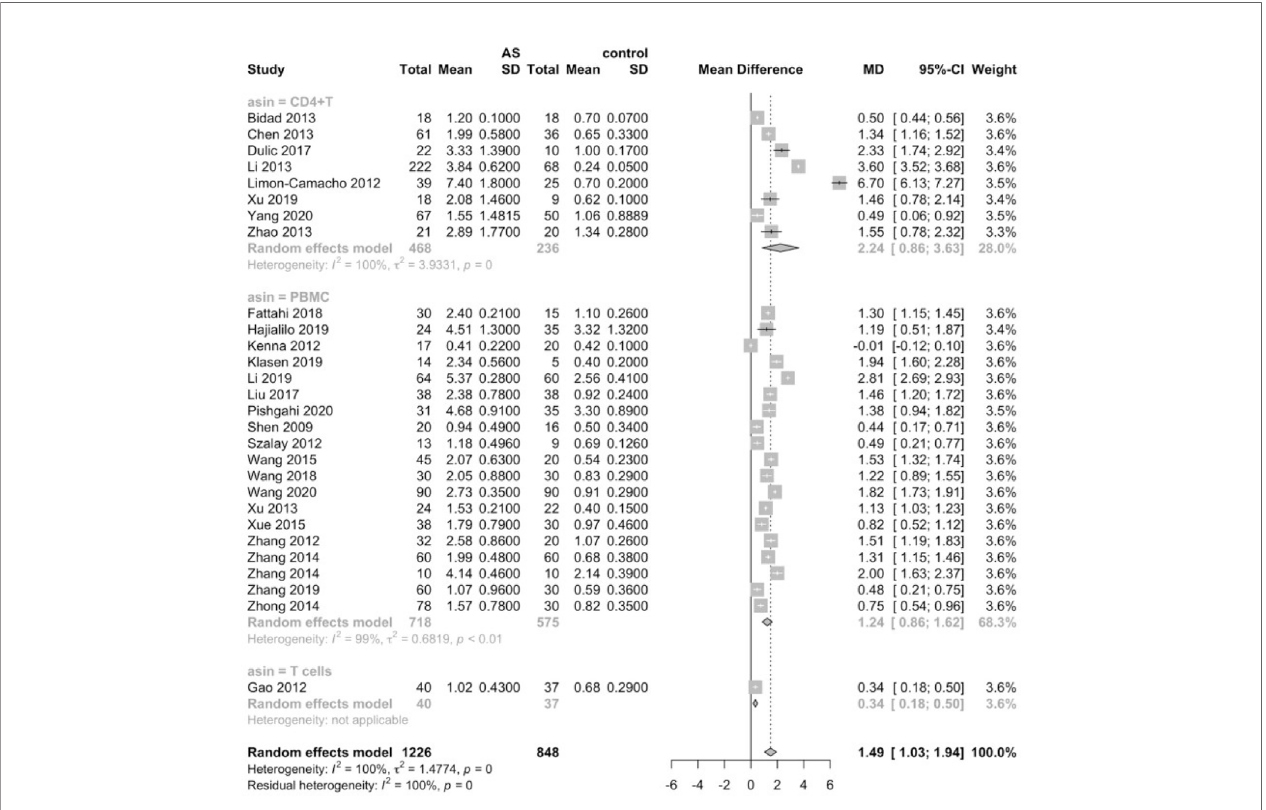
FIGURE 3 | Proportions of Th17 cells among PBMCs, T cells and CD4+